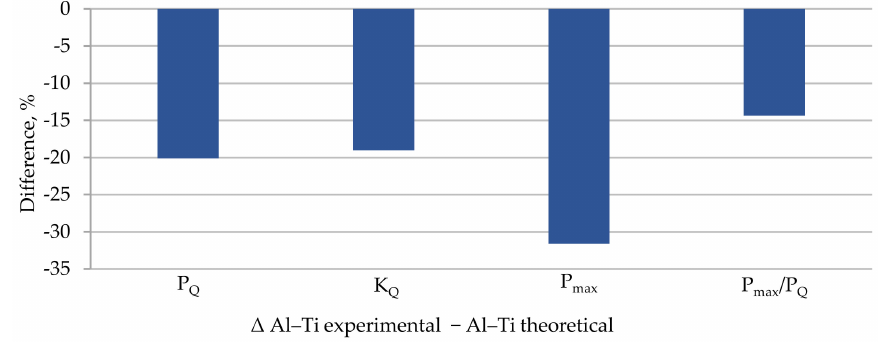
Figure16. Differencesbetweenselectedmechanicalpropertiesobtainedfromexperimentandcalculations for Al–Ti layered material in ambient